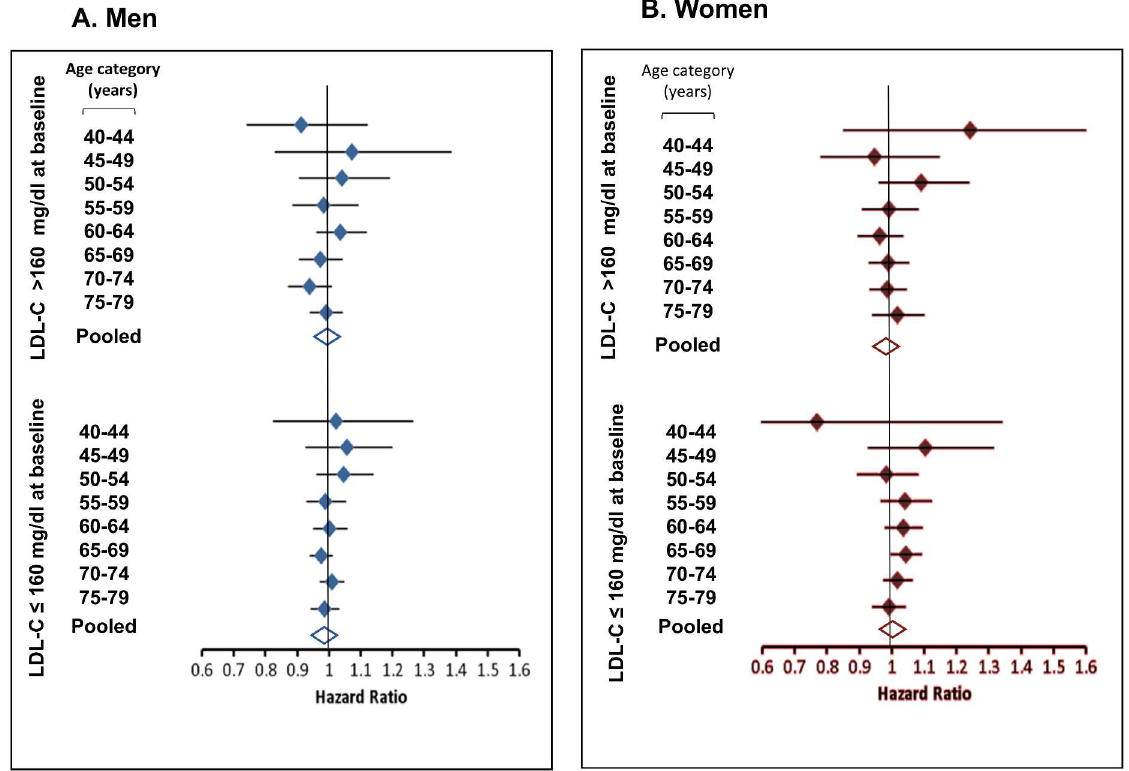
Fig 3. Adjusted Hazard Ratios (HRs) with 95%CIs * for Parkinson’s disease risk associatedwith annual statin adherence (expressed per 10% increasein proportion of days covered) according to sex, LDL-C level at baseline and age category. * Diamond-shapeindicates HR; horizontallines- 95%